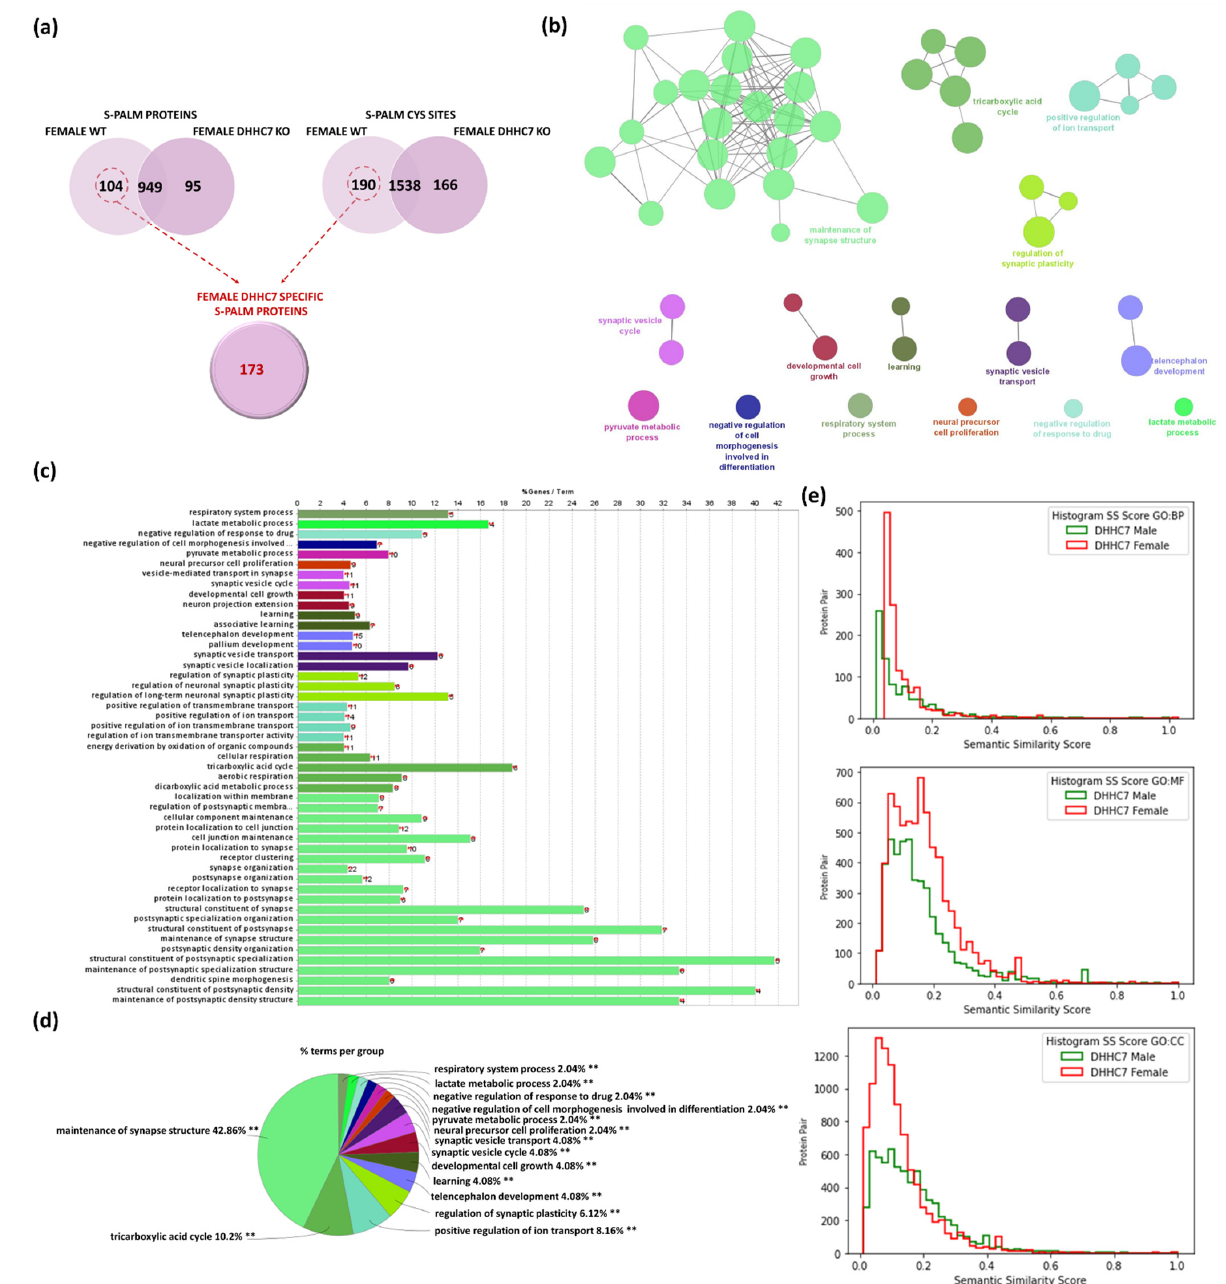
Figure 7. Analysis of female synaptic proteins regulated by DHHC7 using the Gene Ontology biological processes database and the Clue Go algorithm. ( a ) Venn diagram analysis of S-PALM in WT and DHHC7 KO female synaptoneurosomes. ( b ) Network depicting interactions between enriched functional classes. ( c ) List of all enriched GO_BP functional classes ( p < 0.01). ( d ) Percentage of terms per group analysis of enriched protein classes. ( e ) Comparison of semantic similarity (SS) of protein pairs from DHHC7 male and female-specific proteins for each type of Gene ontology terms, cellular components (CC), molecular functions (MF) and biological processes (BP) respectively. X -axis represents the SS score (ranges [0, 1]) and the Y -axis represents the frequency of protein